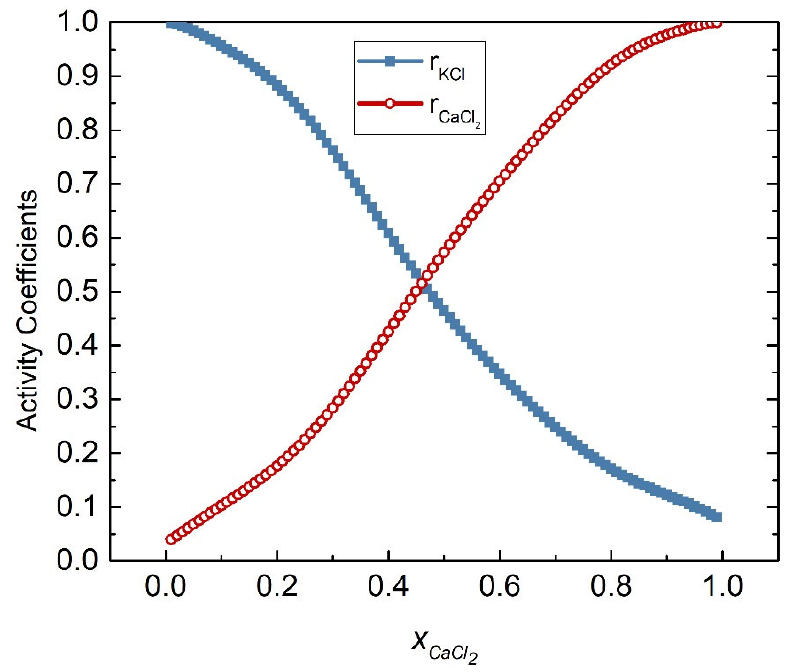
Figure 11. Calculated activity coefficients of each element of the KCl-CaCl 2 system (1058 K). Table 3. Calculated activity values and literature data of the KCl-CaCl 2 binary chloride system at 1058